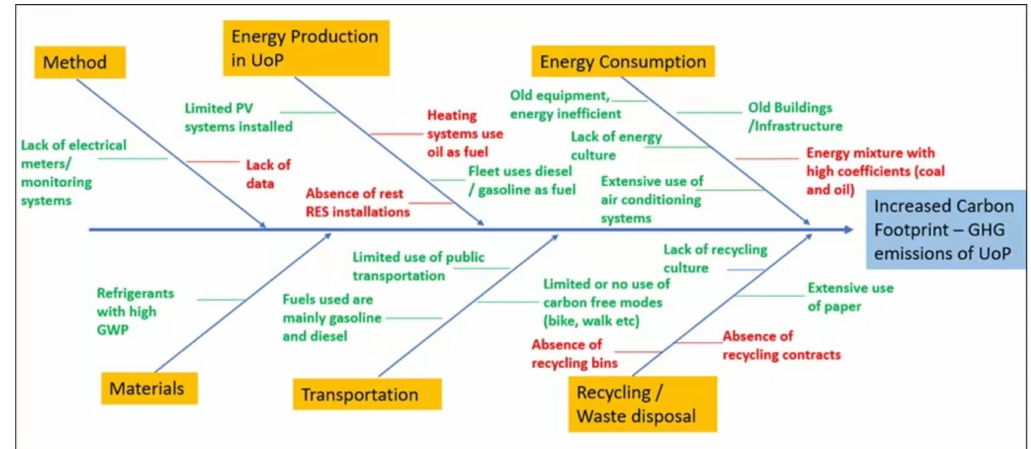
Figure 1. Fishbone diagram.